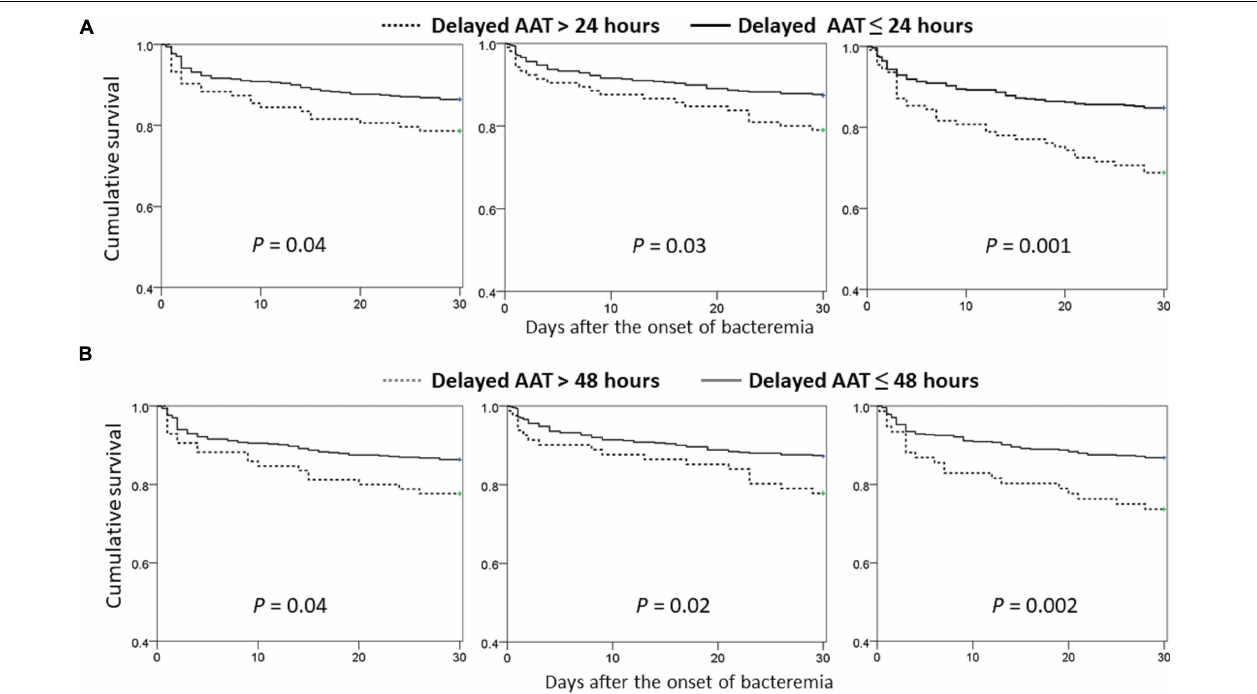
FIGURE 2 | Comparisons of Kaplan–Meier survival curves between the propensity-score-matched patients with delayed AAT > 24 (A) or > 48 (B) hours and those without delayed administration, categorized by the different age groups. AAT, appropriate antimicrobial therapy.